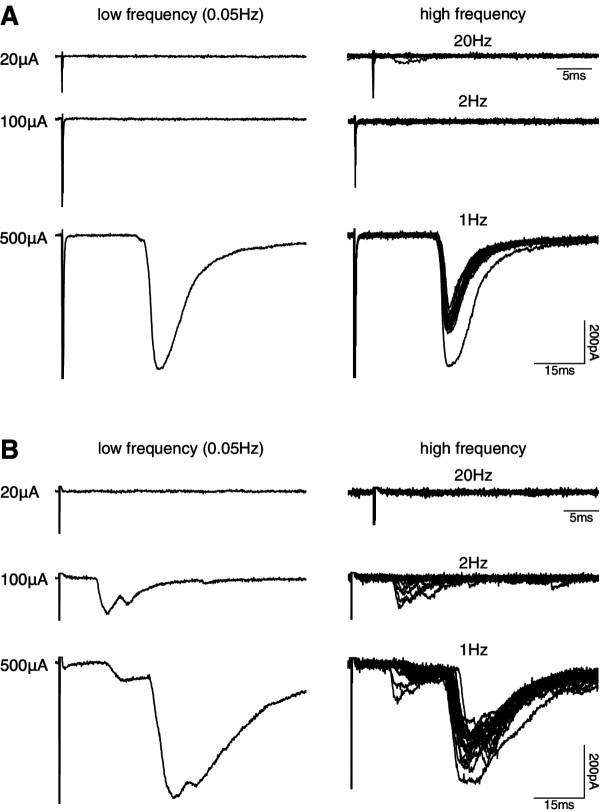
Monosynaptic C-fibre input to lamina I NK1R+ neurons. A. and B. Characterisation of primary afferent input to lamina I NK1R+ neurons receiving monosynaptic C-fibre only and monosynaptic C-fibre with polysynaptic A δ-fibre input, respectively. Left traces show examples of ESPCs evoked by dorsal root stimulation at A β- (20 μA), A δ- (100 μA) and C-fibre (500 μA) intensities, at low frequency (0.05 Hz). Each trace is an average of 3 traces. Right traces show examples of EPSCs evoked using higher-frequency stimulation (20 μA/20 Hz; 100 μA/2 Hz; 500 μA/1 Hz). Each trace comprises 20 superimposed traces.